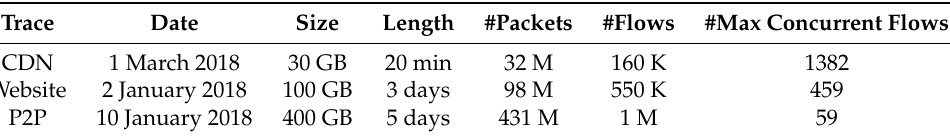
Table 2. Characteristics of three packet traces.